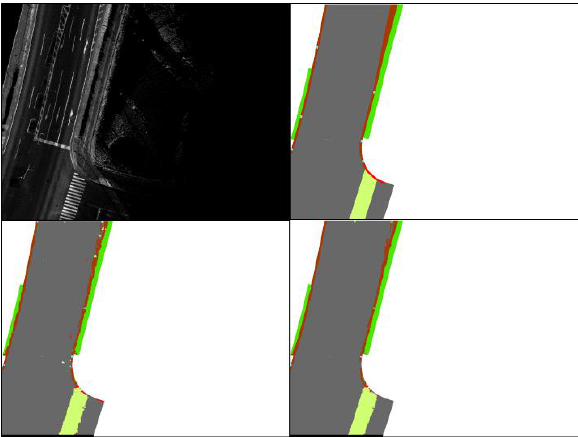
Figure 9. Example of our labeling results. Upper left: input image. Upper right: ground truth label. Lower left: only 48×48 pixels. Lower right: combination of 64×64 pixels and 48×48 pixels.